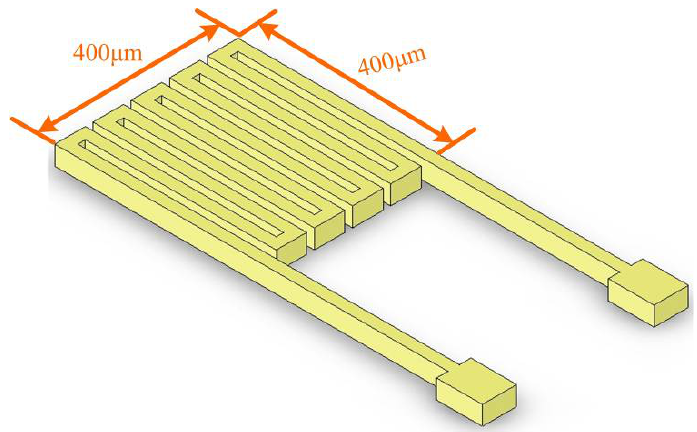
Figure 2. Design of the micro temperature